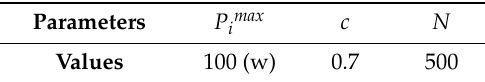
Table 2. Solar utilization percentage under sunny weather condition.